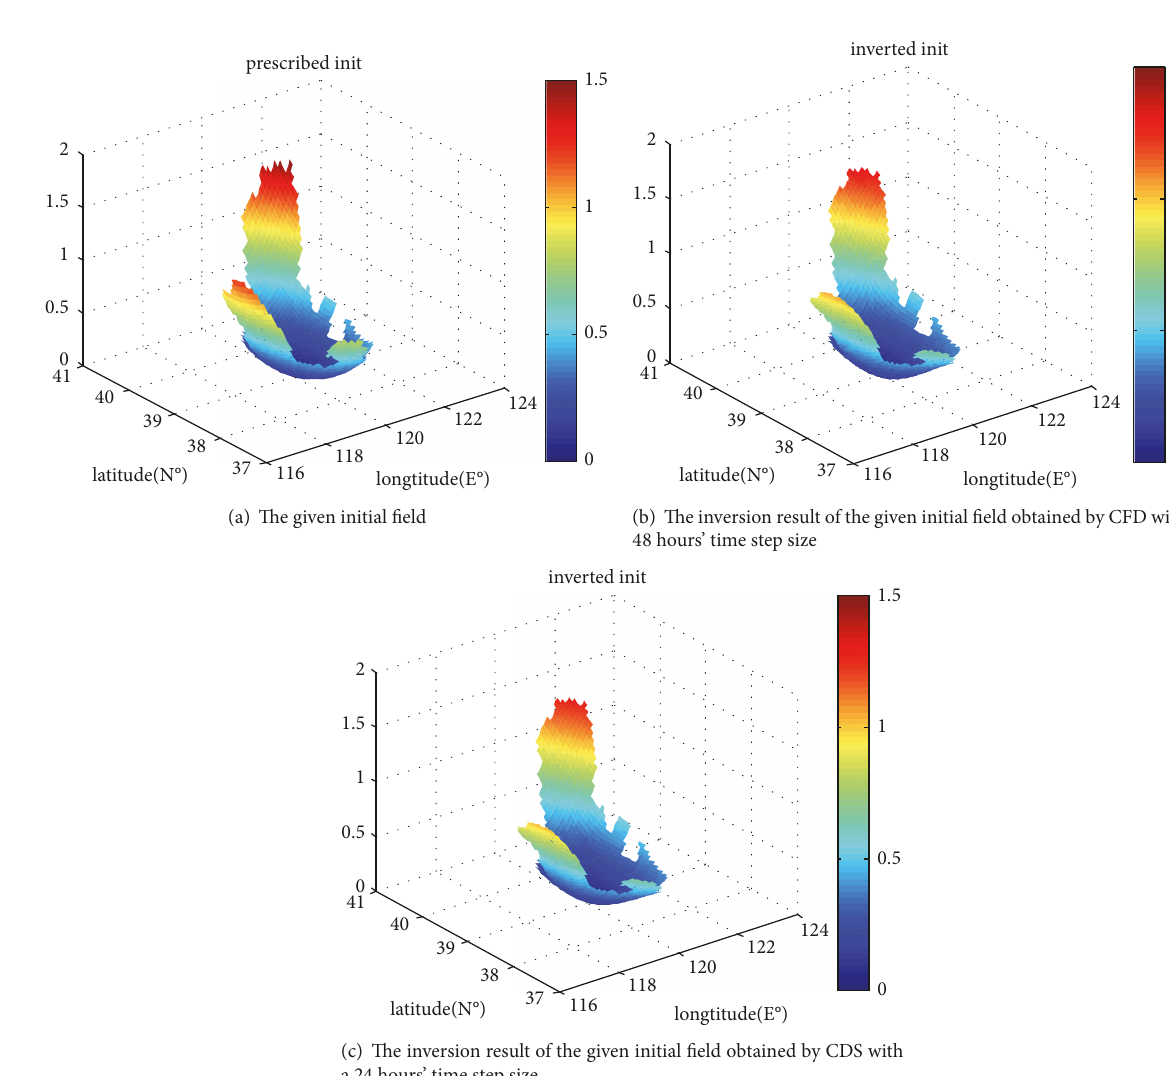
Figure 7: Figures of the initial distribution inverted by the adjoint method of data assimilation with CFD and